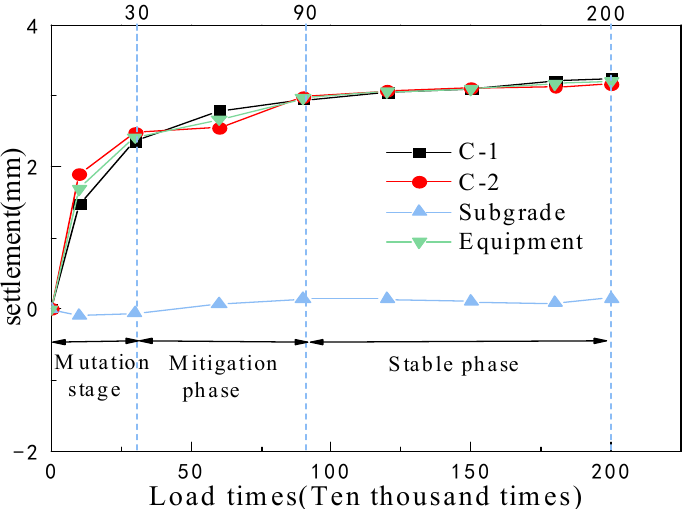
Figure 17. Variation law for cumulative settling with the number of excitations.